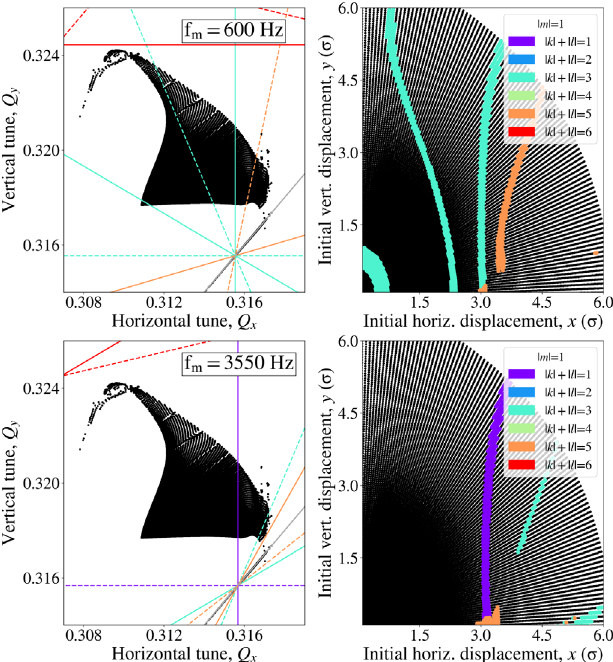
FIG. 10. The footprint (left panel) and the initial configuration space (right panel) for the simulation parameters of Table II and in the absence of power supply ripple (black). The first sideband ( m ¼ 1 ) of N ¼ 1 (purple), N ¼ 2 (blue) N ¼ 3 (cyan), N ¼ 4 (green), N ¼ 5 (orange) and N ¼ 6 (red) resonance is illustrated for a modulation at 600 Hz (top) and 3.55 kHz (bottom) in both tune domain and configuration